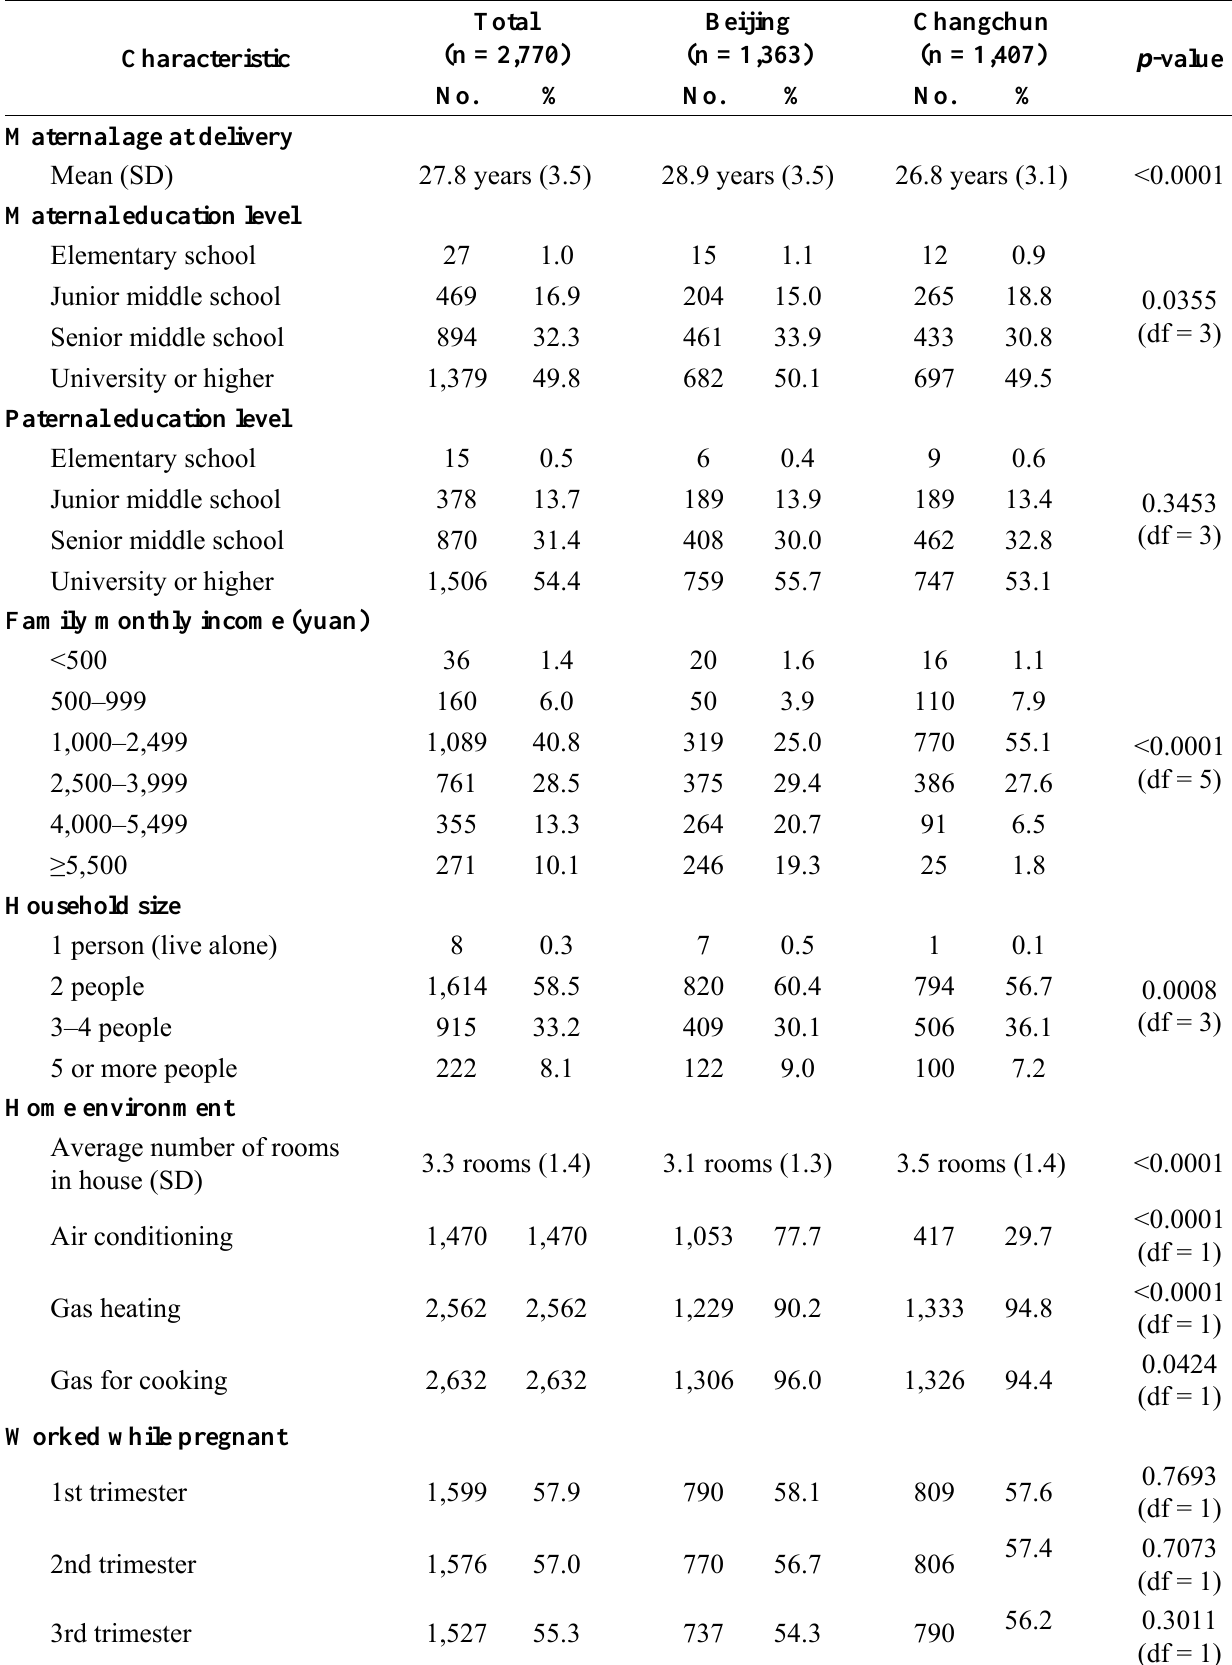
Table 2. Demographic characteristics of study